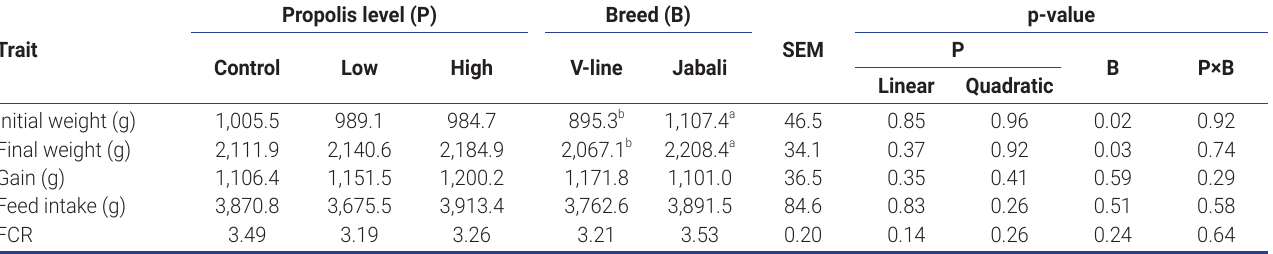
Table 1. Effect of propolis level and breed on body weight, gain and feed conversion ratio in rabbits